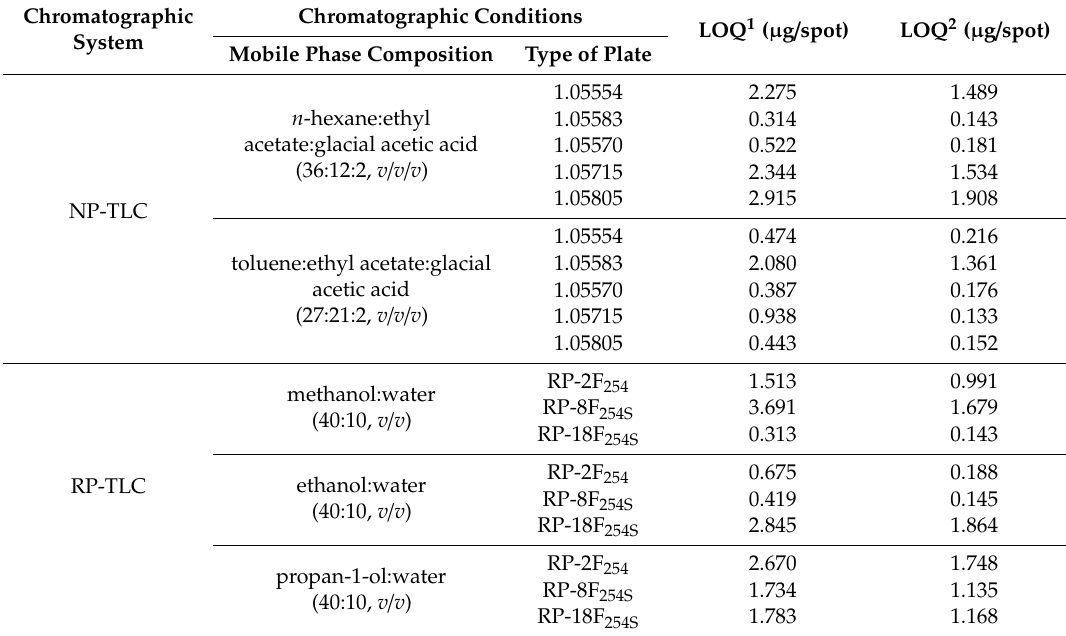
Table 4. Limit of quantification (LOQ) of ibuprofen determined under di ff erent conditions in NP-TLC and RP-TLC systems.